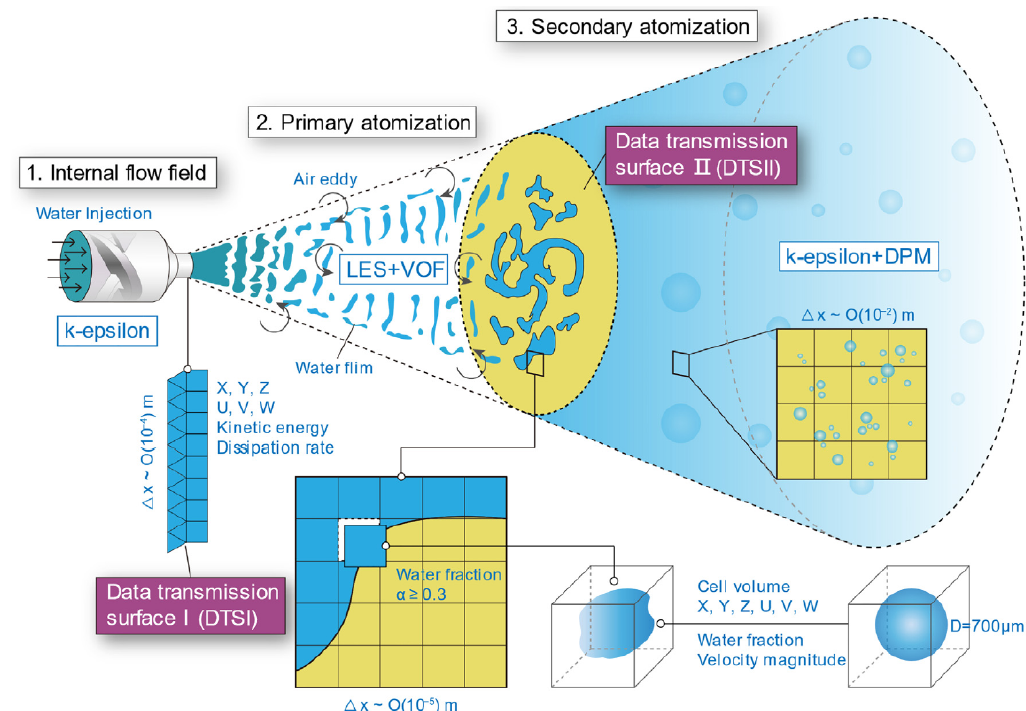
Figure 7. Schematic of the simulation method for investigating the pressure-swirl nozzle [57] .